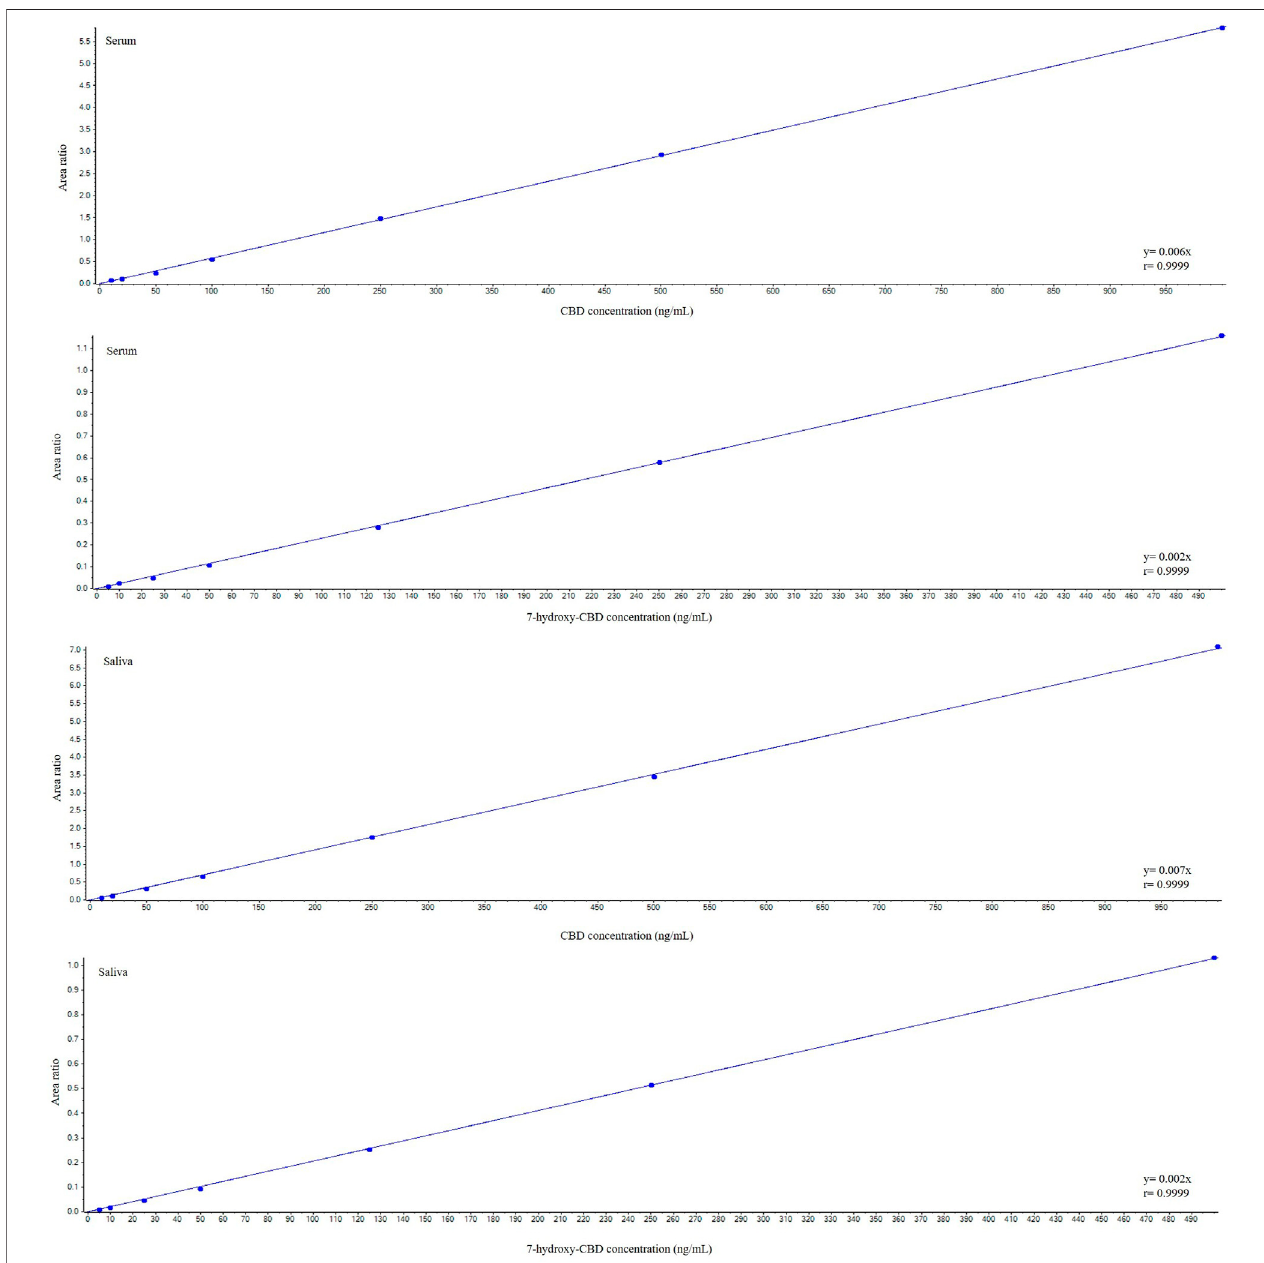
FIGURE 5 | Representative calibration curves for cannabidiol and 7-hydroxy-cannabidiol. CBD, cannabidiol.